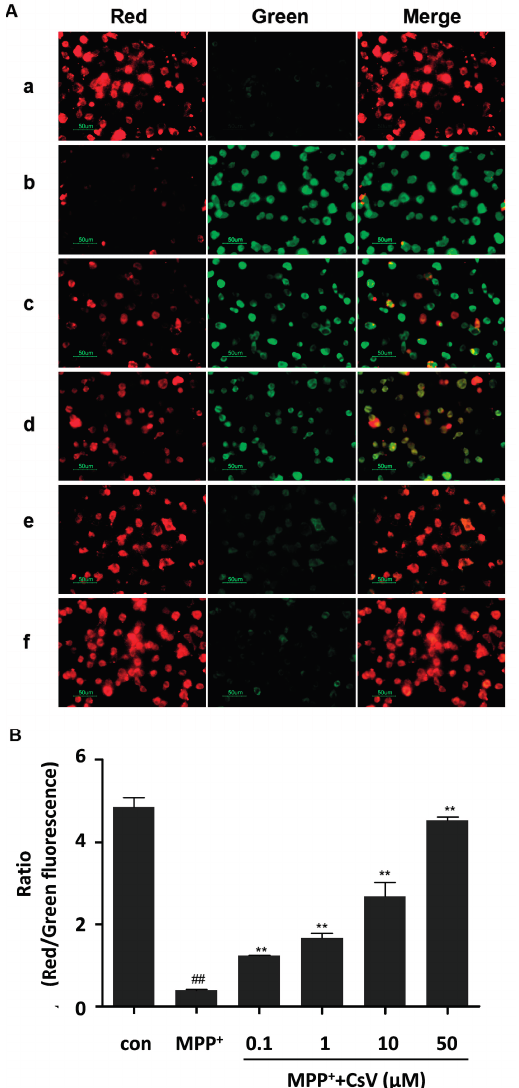
Figure 3. CsV restored MPP + -induced mitochondrial membrane potential in SH-SY5Y cells. ( A ) Mitochondrial membrane potential was detected by JC-1 staining. Images are shown as representative from five independent experiments at 400× magnification. Scale bar: 50 µm. ( a ) control (cells without MPP + and CsV); ( b ) 1 mM MPP + treatment alone; ( c ) 0.1 µM CsV with 1 mM MPP + ; ( d ) 1 µM CsV with 1 mM MPP + ; ( e ) 10 µM CsV with 1 mM MPP + ; and ( f ) 50 µM CsV with 1 mM MPP + ; and ( B ) Ratio of red/green fluorescence. ## p < 0.01 vs. control group, ** p < 0.01 vs. MPP + treated alone. Data are expressed as means ± SD ( n =